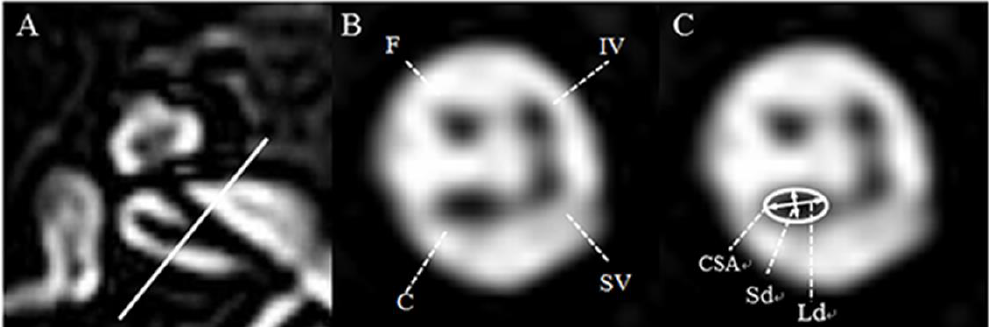
Figure 1. Axial and oblique sagittal three-dimensional (3D) T2-VISTA MRI of the normal ear at the level of the internal auditory canal. ( A ) The oblique sagittal image was established with the baseline perpendicular to the course of the nerve in the midpoint of internal auditory canal (IAC) of an axial image. ( B ) In the anterior aspect of the IAC, the facial nerve lies superiorly, whereas the cochlear nerve lies inferiorly. In the posterior aspect of the IAC, the superior vestibular nerve lies superiorly, whereas the inferior vestibular nerve lies inferiorly. ( C ) For the evaluation of cochlear nerve integrity, the short diameter (Sd, mm), long diameter (Ld, mm), and cross-sectional area (CSA, mm 2 ) were measured as indicated. F: facial neve, C: cochlear nerve, SV: superior vestibular nerve, IV: inferior vestibular nerve. The mean of Ld, Sd, and CSA in the unaffected ears from the present study were 1.19 ± 0.13 mm, 0.95 ± 0.16 mm, and 0.89 ± 0.18 mm 2 , respectively (Figure 2).